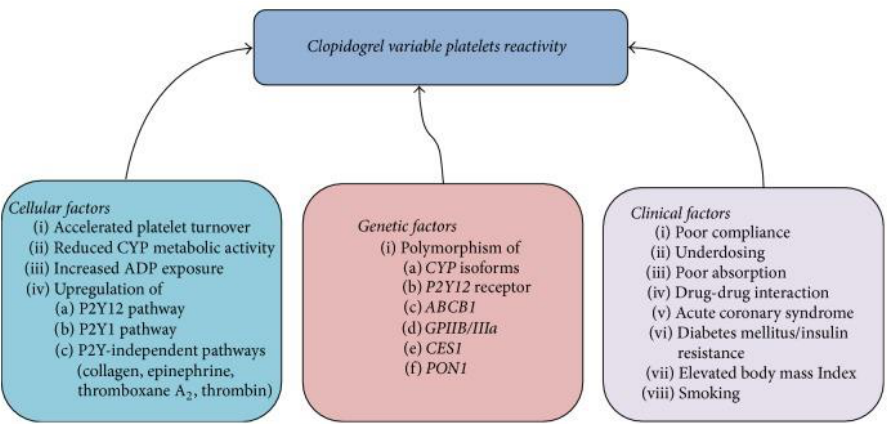
Figure 3. Conventional and Genetic Regulators of Response. Conventional clinical (and cellular) factors and also genetic other factors regulate response to clopidogrel. ABCB1 : ATP-Binding Cassette Subfamily B Member 1; ADP: adenosine diphosphate; CES : Carboxylesterase 1; CYP: cytochrome P450, particularly CYP2C19; GPIIB/IIIa : Glycoprotein IIB/IIIa; PON1 : Serum paraoxonase/arylesterase 1; P2Y: receptor on the surface of platelets. Used with permission of Creative Commons; copyright 2017 [11]; originally adapted from [128].